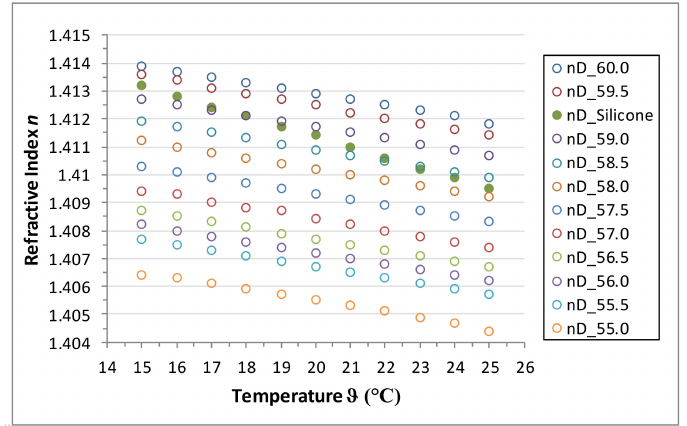
Figure 6. Refractive indices of aqueous glycerol solution and Elastosil ® RT 601 as function of temperature.